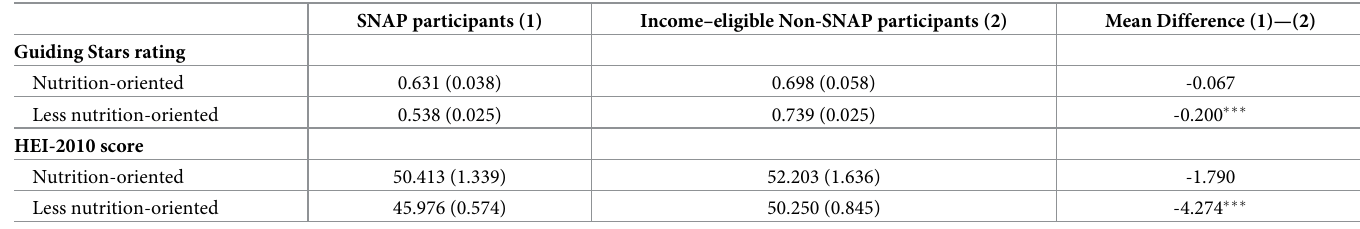
Table 2. Comparison of Guiding Stars rating and HEI-2010 score between SNAP and low-income non-SNAP households by nutrition